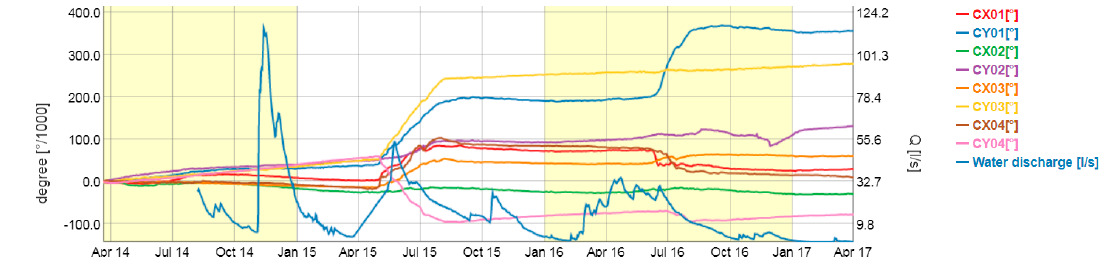
Figure 11. Rotation of the two-axis clinometers plotted with the water discharge inside the drainage system within the road tunnel—the graph has been produced directly through the web-based platform.